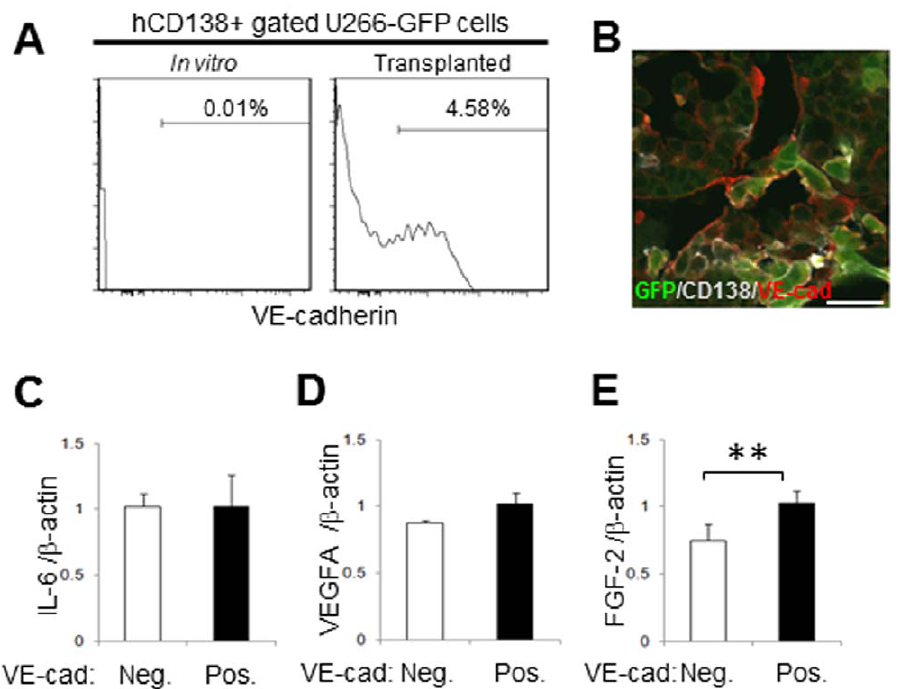
Figure 3. MM cells express VE-cadherin and form endothelial-like structures in the BM. A. Flow cytometric detection of VE-cadherin in U266-EGFP cells in vitro (left) or transplanted U266-EGFP cells (right) using anti-human VE-cadherin antibody. The experiment was performed with more than twenty mice with similar results. B. Triple IHC of GFP (green), human CD138 (gray) and VE-cadherin (red) within the diaphyseal region at 4 weeks after U266-EGFP cell transplantation. Representative data from four fields from the BM of three mice in two independent experiments are shown. Bars=20 m m. C–E . Quantitative PCR analysis of IL-6 ( B ), VEGFA ( C ) or FGF-2 ( D ) transcripts in the VE-cadherin + or VE-cadherin 2 MM fractions five weeks after U266-EGFP cell transplantation. Each value was normalized to b -actin expression and is expressed as the fold induction compared to VE-cadherin + samples (mean 6 SD, ** P , 0.01, n=4). The experiment was performed twice with similar results.